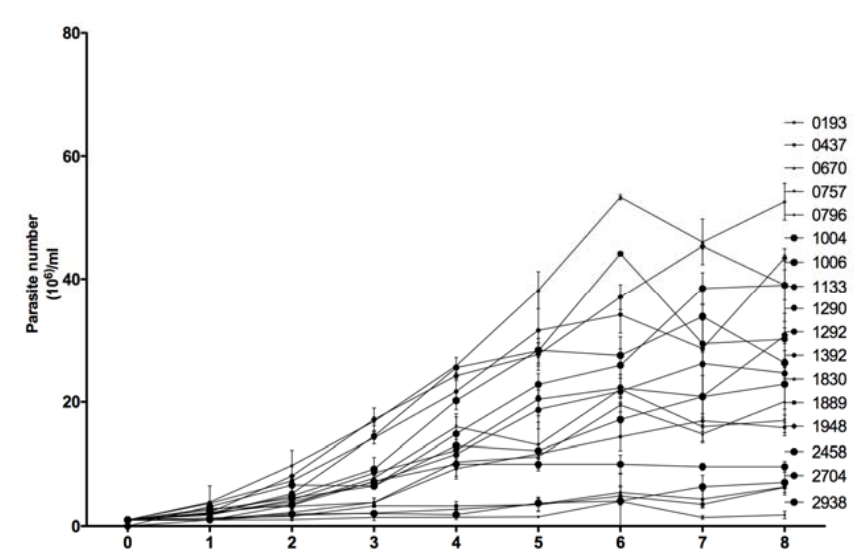
Figure 5. In vitro growth kinetics of the 18 L. major isolates. Parasites were cultured at the initial concentration of 1 × 10 6 parasites per mL and counted every day during 8 days by three different operators. The mean and standard deviation are presented for each isolate. The results correspond to one representative experiment out of at least three ones performed for each isolate. a p value less than 0.01.